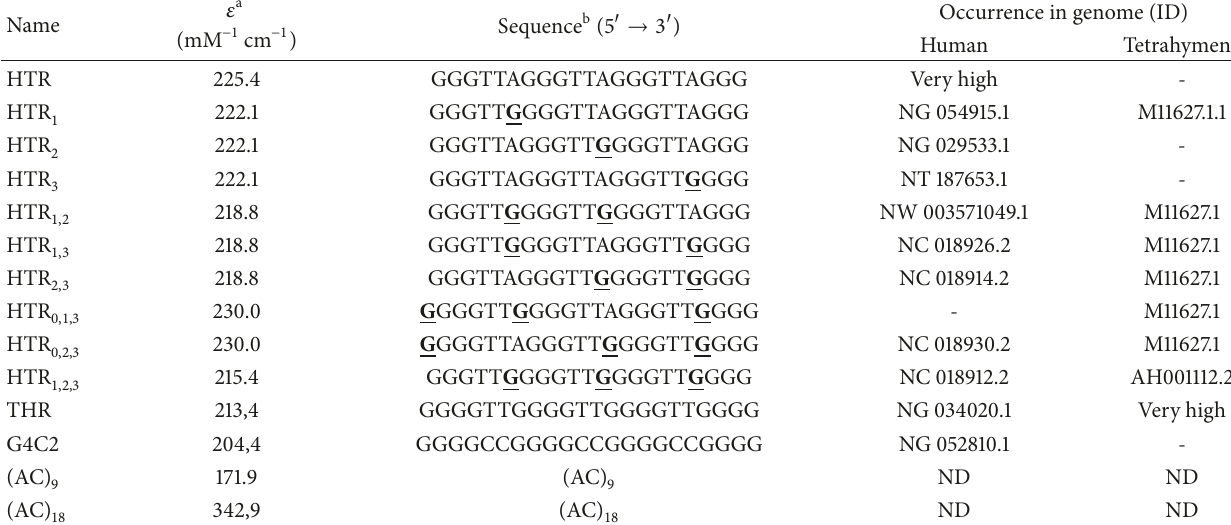
Table 1: DNA oligodeoxynucleotides used in this study and their occurrence in human and Tetrahymena genomes.